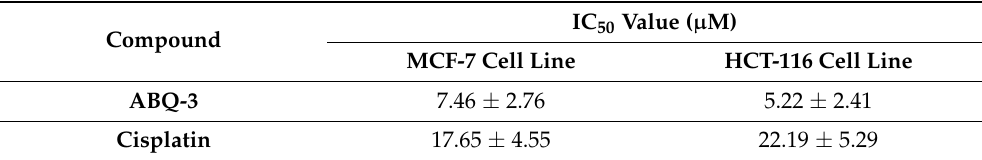
Table 3. The cytotoxicity of ABQ-3 on breast cancer and CRC cells, based on MTT assay at five dose concentrations (1, 3, 10, 30, and 100 µ M).